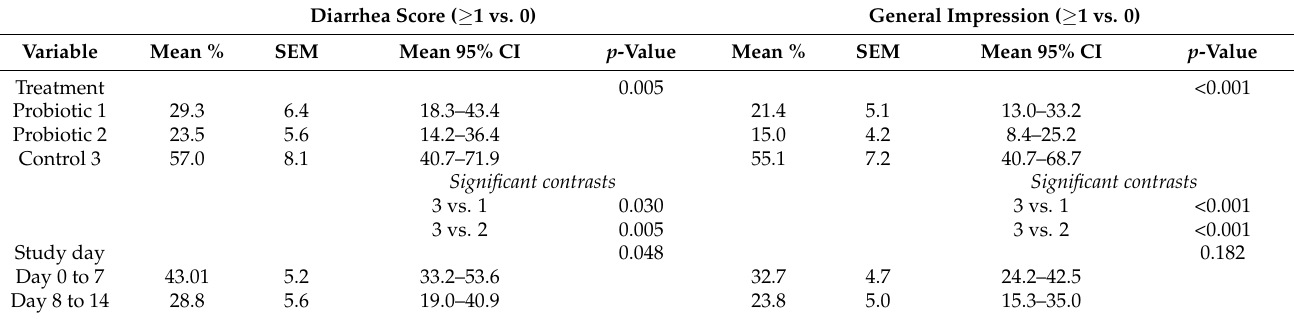
Table 7. Diarrhea and general impression scores modeled as dichotomous outcomes estimated from multivariable models a among dairy calves supplemented with two probiotic products to reduce Clostridium perfringens . Diarrhea Score ( ≥ 1 vs. 0)